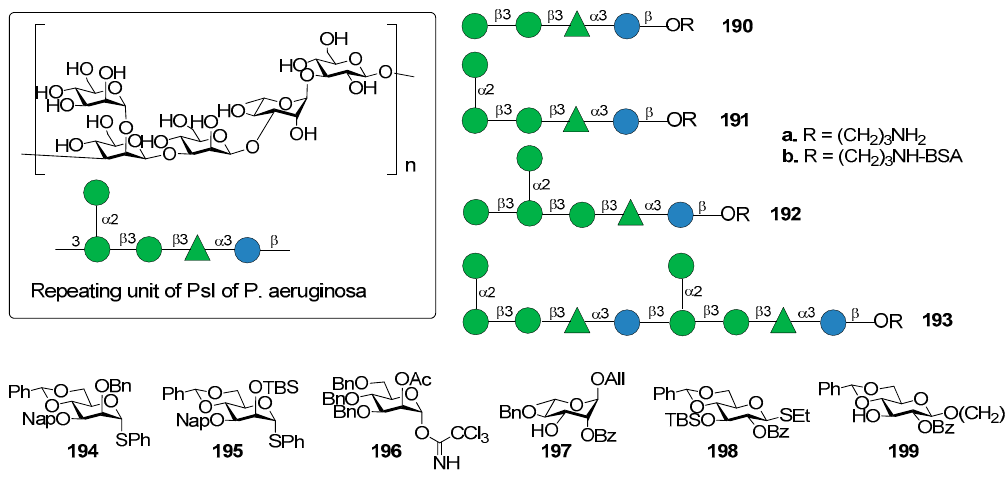
Figure 22. Repeating unit of PsI of P. aeruginosa and synthetic fragments reported in Reference [158].